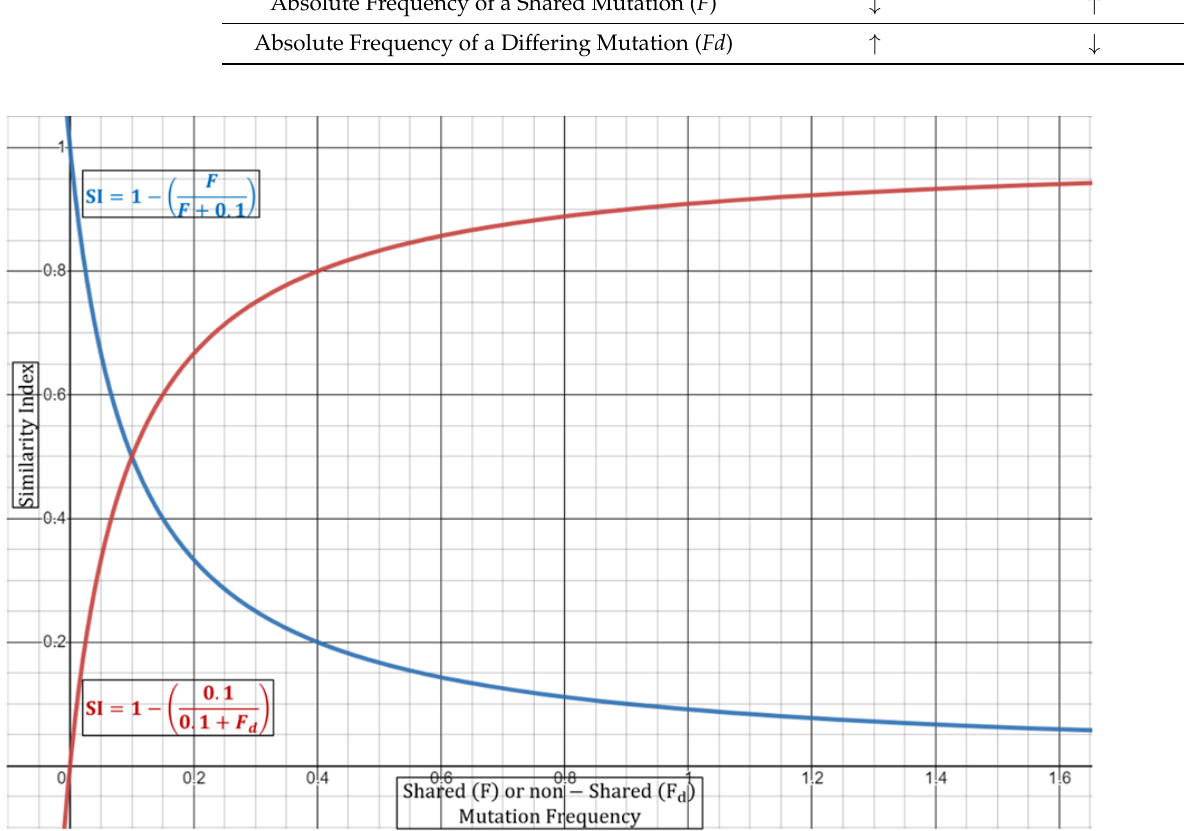
Figure 2. Graphical representation of modified Equation (3). Shared ( F ) or non-shared ( Fd ) combined frequencies oppositely shift the Similarity Index towards or away from 1 (100%). Blue line represents constant combined frequency of non-shared mutation with variable frequencies of shared mutations. Red line represents constant combined frequency of shared mutations with variable frequencies of non-shared mutations.